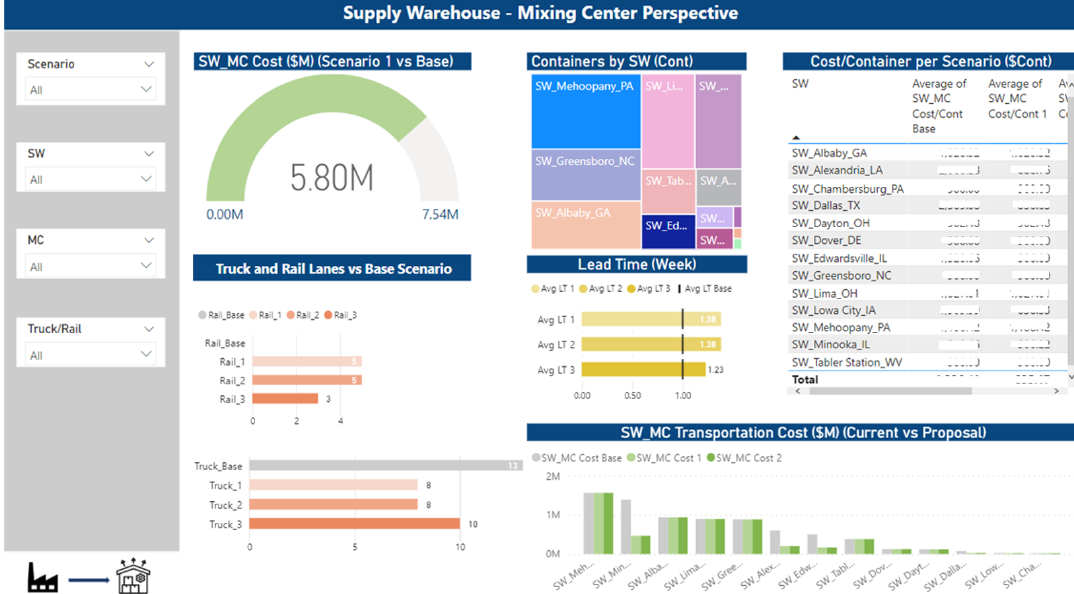
Figure A2. Summary of Supply Warehouse to Mixing Center Perspective. The legend corresponds to the notation introduced in Section 4.3.1. The values for current rates, new contract assumptions, and costs are sensitive data and intentionally covered.